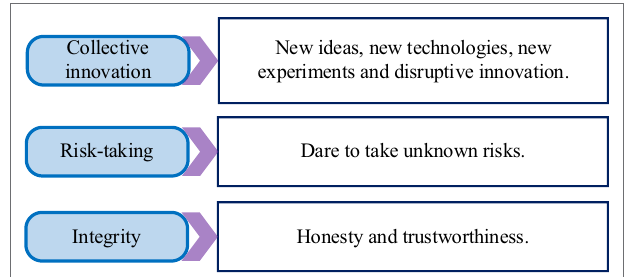
FIGURE 1 | Dimensions and connotations of